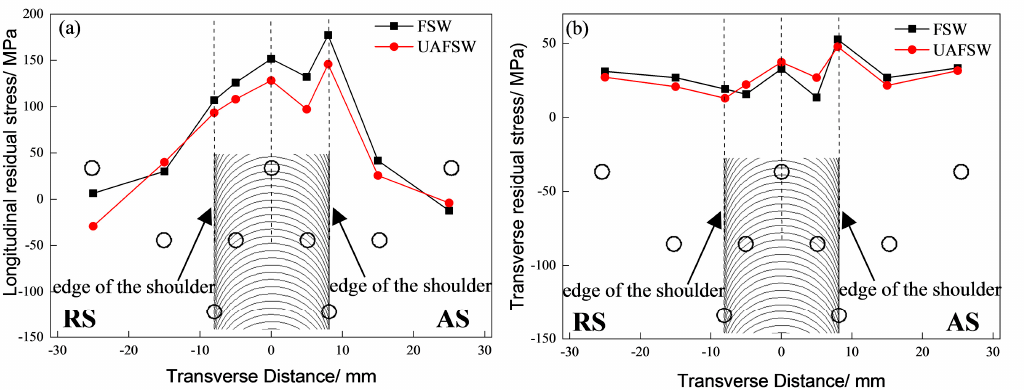
Figure 6. Residual stresses for the FSW and UAFSW joints: ( a ) Longitudinal residual stresses and ( b ) transverse residual stresses.